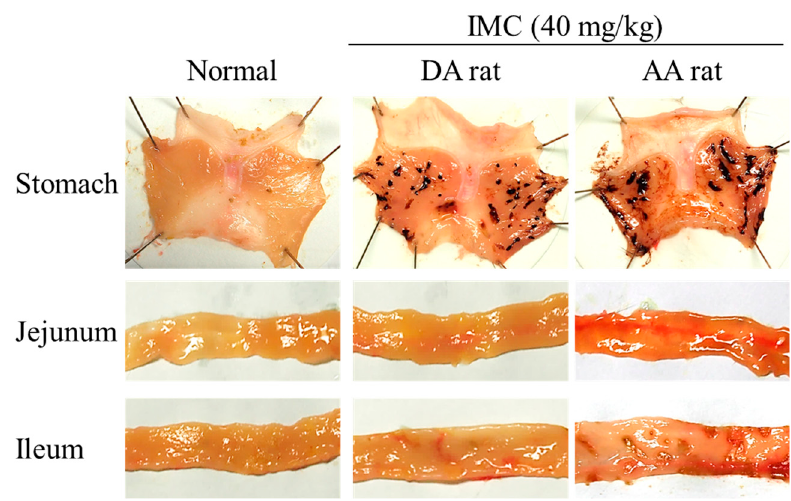
Figure 5. Representative images of indomethacin (IMC)-induced gastrointestinal (GI) bleeding in normal and adjuvant-induced arthritis (AA) rats. The images were obtained 24 h (stomach) or 48 h (jejunum and ileum) after the oral administration of excessive IMC (40 mg/kg). Normal: normal dark agouti (DA) rat (non-treatment); IMC + DA rat: IMC-stimulated DA rat; IMC + AA rat: IMC-stimulated AA rat. In the stomach, jejunum, and ileum, GI bleeding was caused by excessive IMC stimulation, and the levels of GI lesions in the AA rats were significantly higher than in DA rats (non-AA rats).